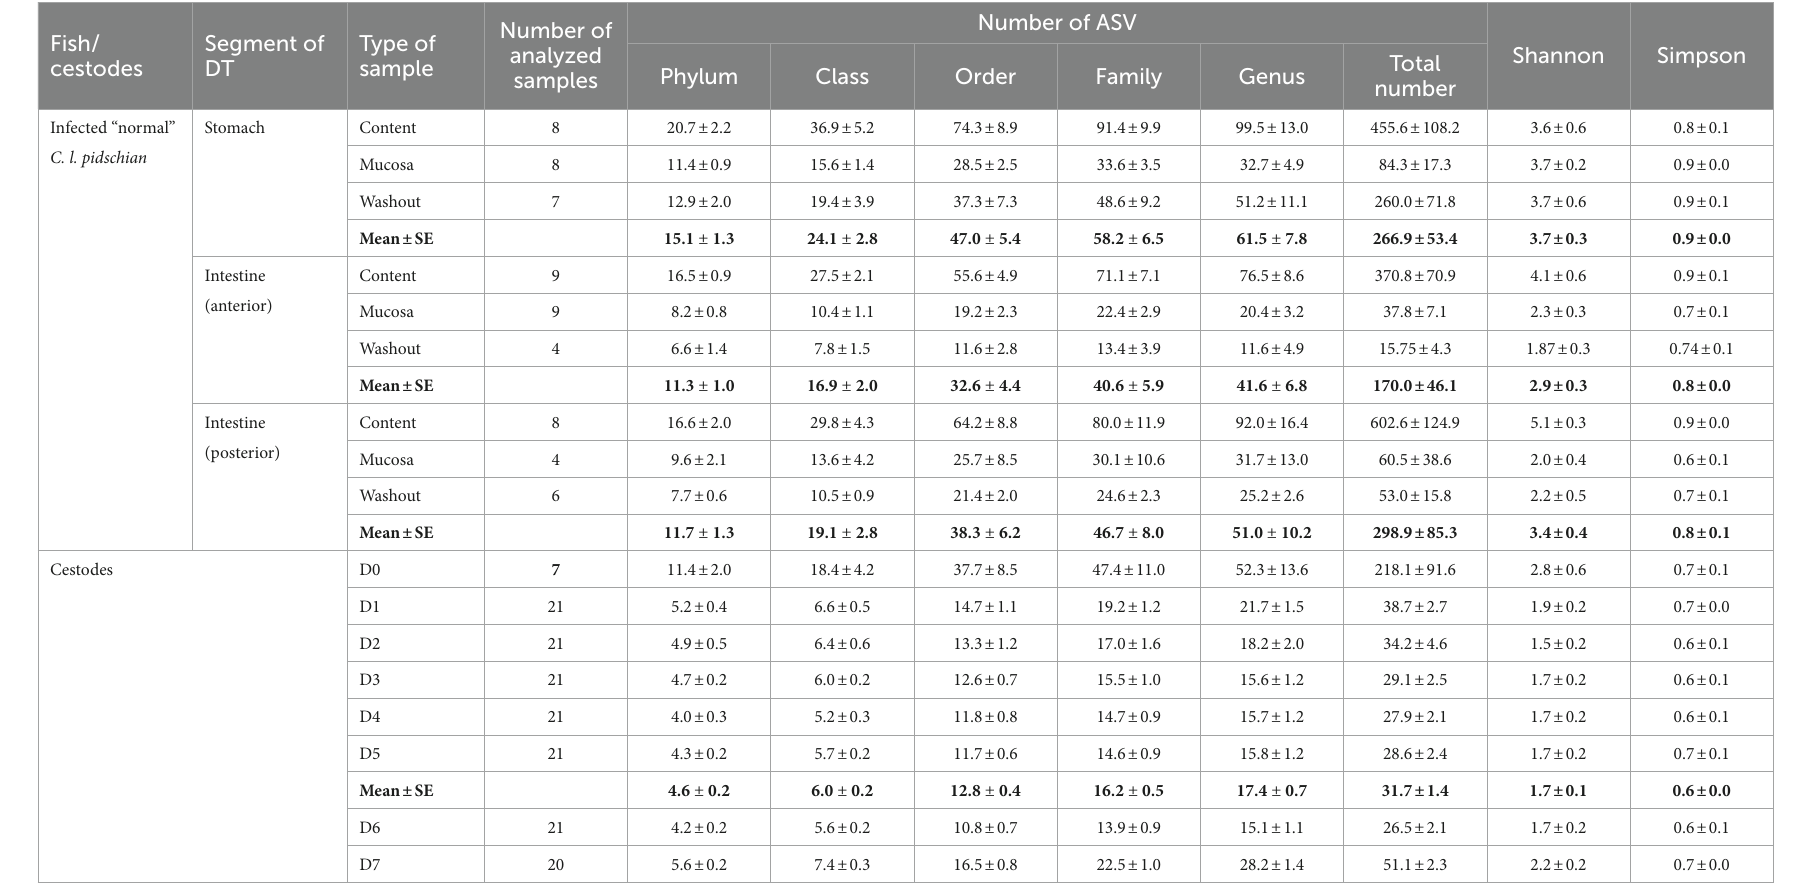
The bold character indicates mean and standard